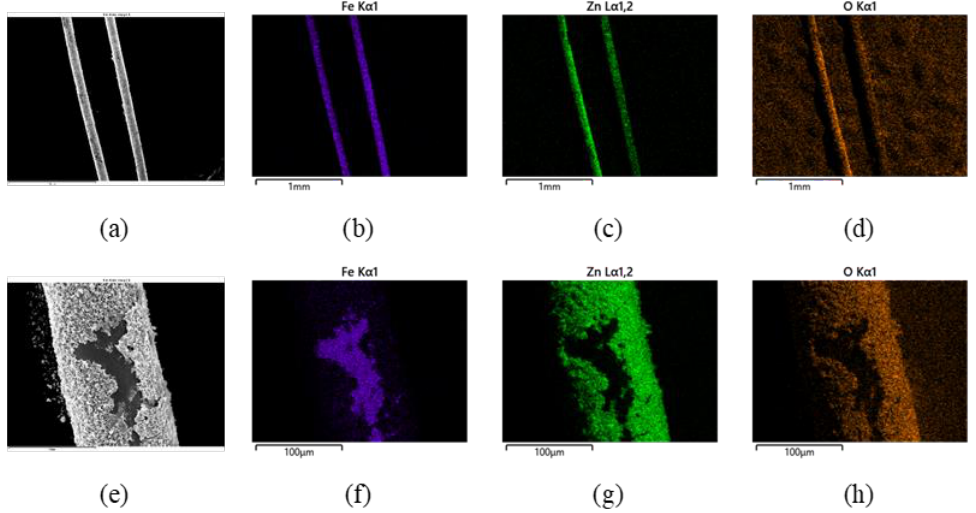
Figure 8. SEM-EDX analysis of the amorphous fibres coated via the hydrothermal technique using a precursor solution of 0.25 M concentration and a deposition duration of 6 h. ( a , e ) — SEM images, ( b , f ) — distribution maps of the Fe, ( c , g ) — distribution maps of the Zn, ( d , h ) — distribution maps of the O.